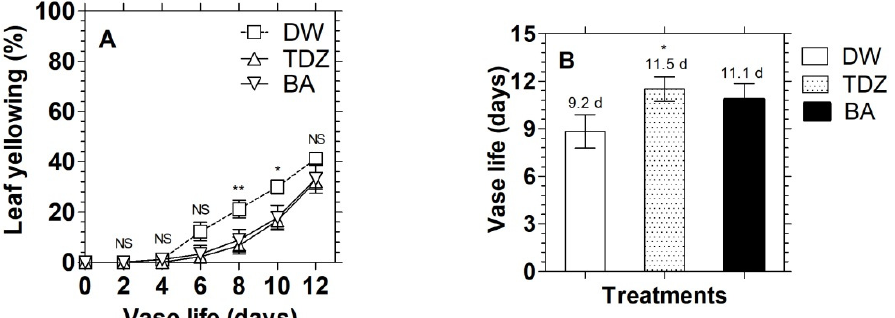
Figure 3. Effect of CKs on yellowing ( A ) and vase life ( B ) of D. solida leaves. Leaves were pulsed with distilled water (DW; control), 10 µ M TDZ, 100 ppm BA for 24 h, then transferred to distilled water in a controlled environment room for the vase period. Asterisks above the curves at each time point represent significant differences between treatments according to Duncan’s multiple range test (DMRT); p < 0.01 (**) and p < 0.05 (*), NS not significant. The numbers above columns represent the values of vase life days.